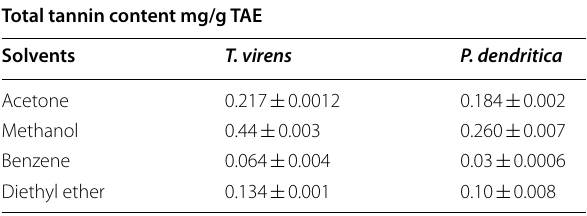
Table 5 Quantitative estimations of total tannin Total tannin content mg/g